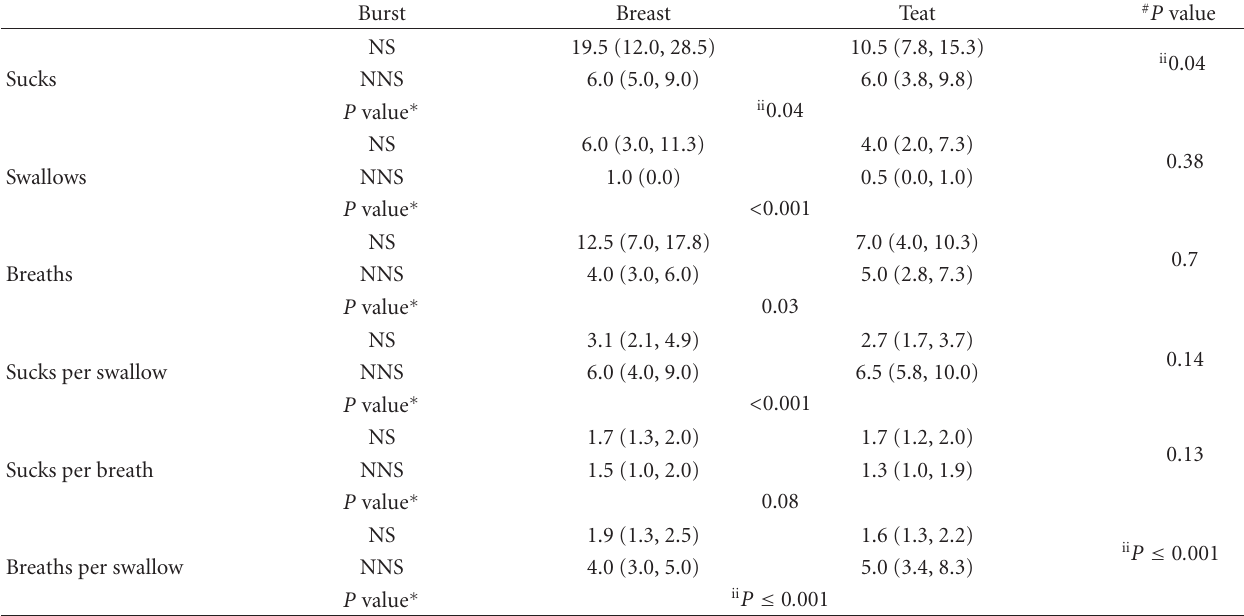
Table 3: Number of sucks, swallows, and breaths per burst and the suck:swallow: breathe (SSwB) ratios during the monitored breastfeed and the feed from the experimental teat during nutritive (NS) and non-nutritive (NNS) sucking.